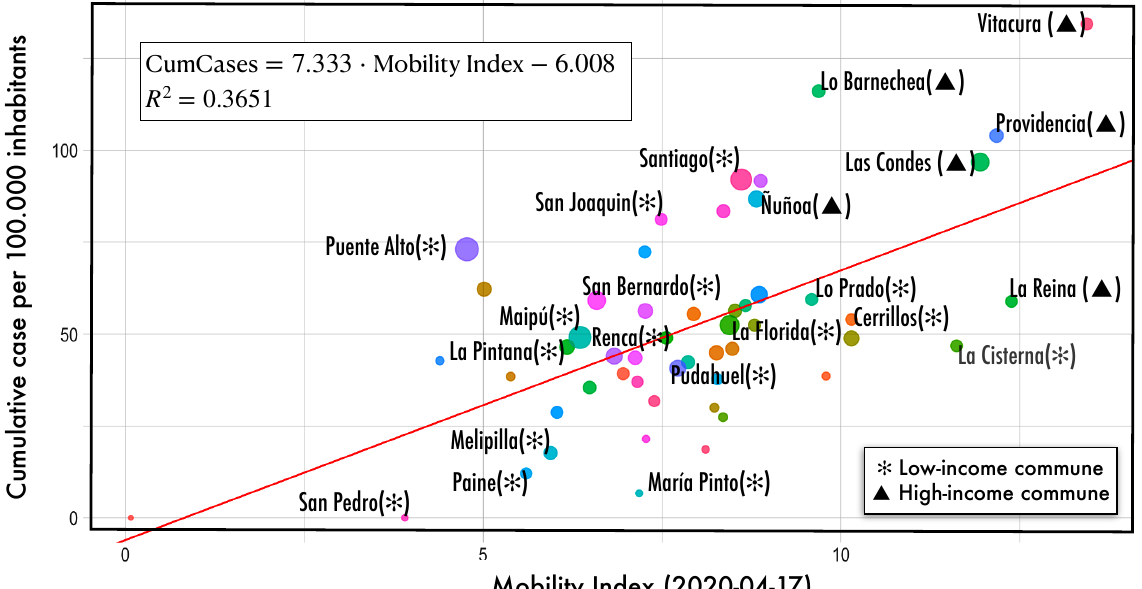
Figure 11. Mobility index vs. cumulative number of cases per 100.000 inhabitants of the commune at the beginning of the total quarantine for the communes of the Metropolitan Region. The radii of the bubbles are proportional to the commune